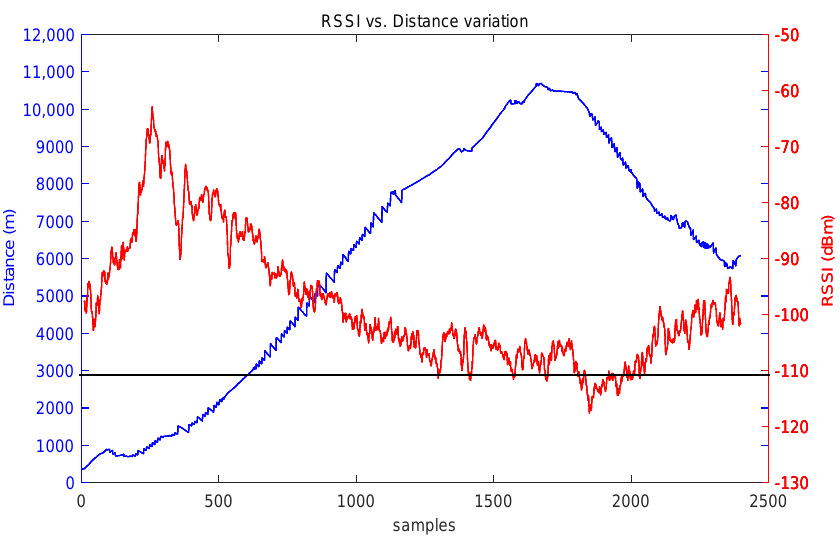
Figure 26. RSSI (Receiver Signal Strength Indicator) variation with the ship-to-shore